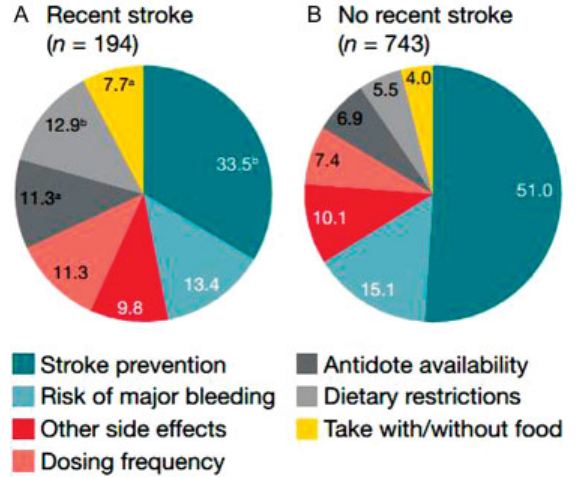
Fig.3 The mostimportant factor in the choice oforal anticoagulation rated by atrial fi brillation patients with a recent stroke ( A ) and those without a recent stroke ( B ). a p < 0.05 versus no recent stroke. b p < 0.001 versus no recent stroke. Percentages do not always equal to 100 due to